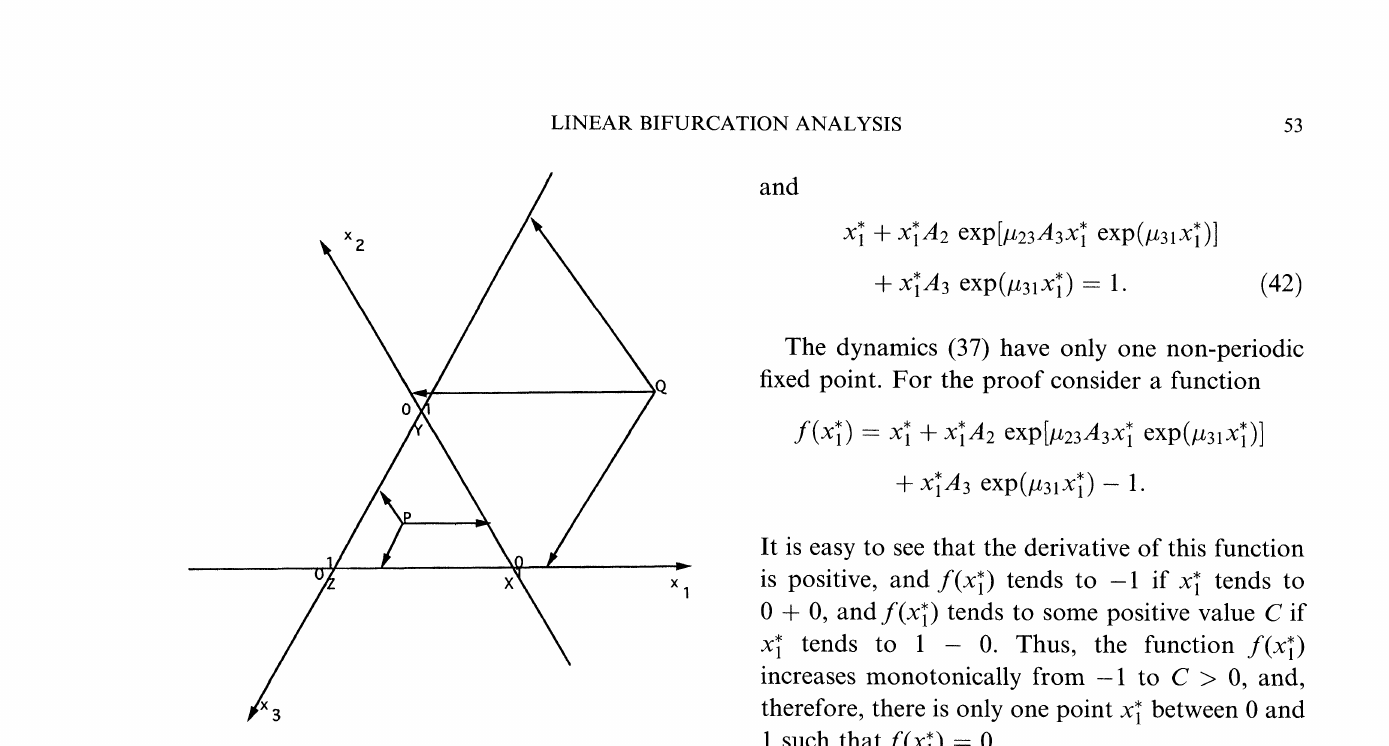
FIGURE 2 Barycentric coordinates in Meobius